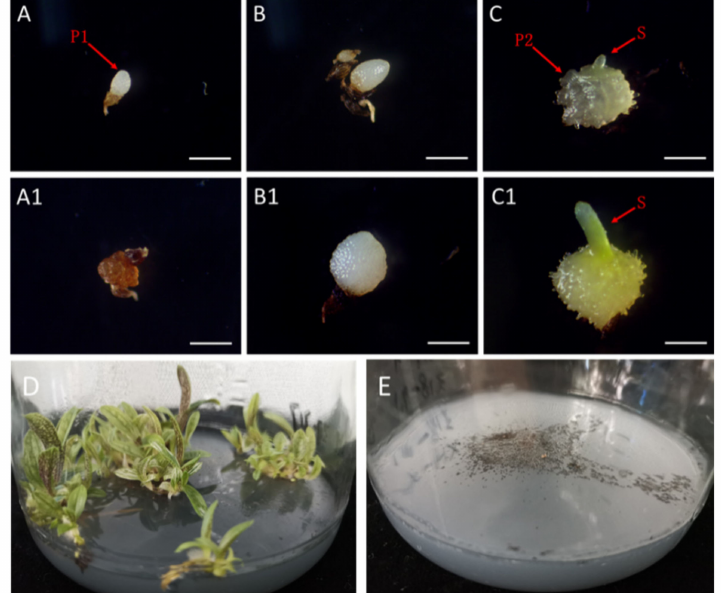
Figure 8. Protocorm and plantlet formation from immature and mature seeds of P. armeniacum. Protocorm was formed from immature seeds harvested at 73 DAP after 60 days cultivation ( A ), which failed to develop further and turned brownish after 160 days cultivation ( A1 ). Protocorm was formed from immature seeds harvested at 94 DAP after 60 days cultivation ( B ), which enlarged slowly and failed to develop shoots after 140 days cultivation ( B1 ). Protocorm was formed from mature seeds harvested at 124 DAP after 60 days cultivation ( C ), which rapidly enlarged and developed a shoot on top after 70 days of cultivation ( C1 ). The plantlet was able to grow properly from mature seeds harvested at 124 DAP ( D ). The over-mature seeds harvested at 157 DAP failed to germinate due to the physical restriction imposed by lignin accumulation ( E ). P1: growth-arrested protocorm; P2: properly developed protocorm; S: shoot formed from the top of the protocorm; Scale bar = 0.5